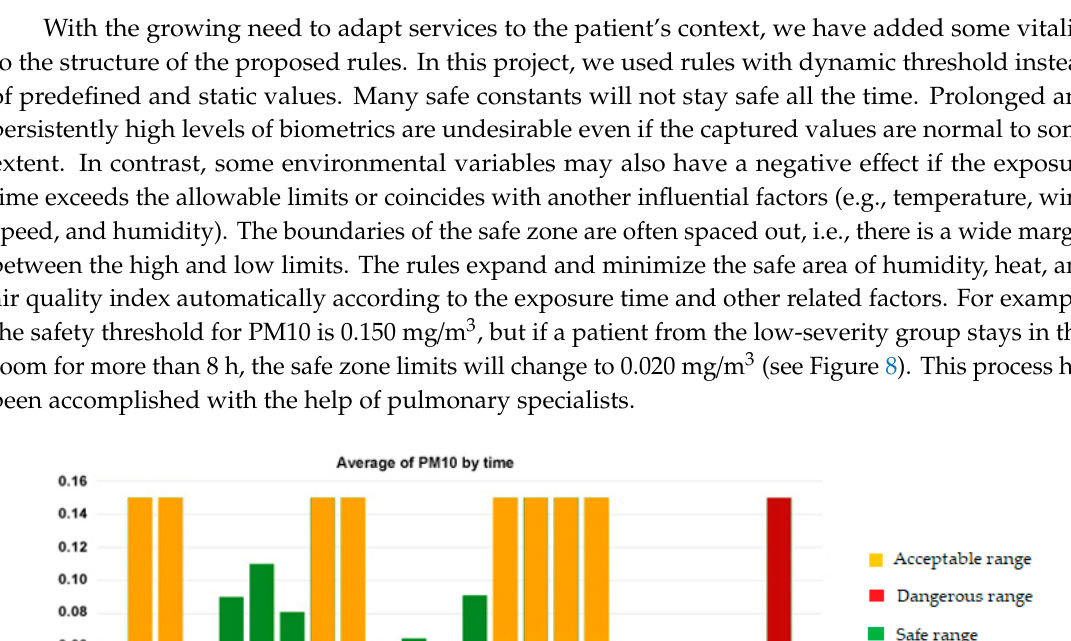
Table 3. Weather alarms and constraints for a specific profile.